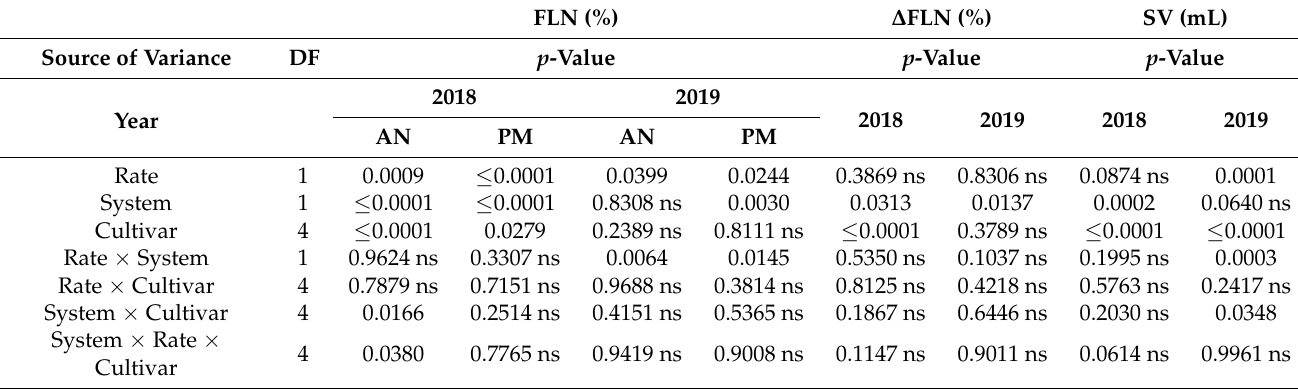
Table A2. ANOVA values for flag leaf nitrogen (FLN, %) at anthesis (AN) and physiological maturity (PM), change in flag leaf nitrogen ( ∆ FLN, %) and sedimentation value (SV, mL). Values were considered significant of the α ≤ 0.05 level, with non-significant effects indicated by annotation as